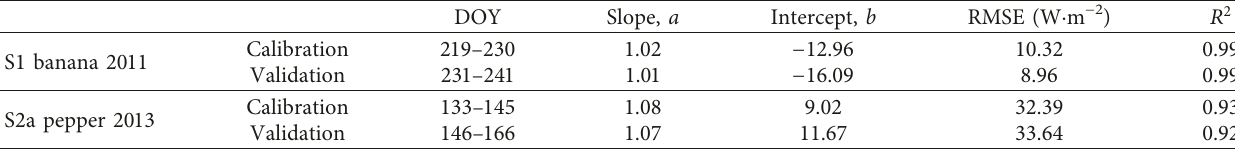
Figure 8: The latent heat flux estimated based on FV technique, LE FV , versus the one estimated by forcing the energy balance closure, S1 banana screenhouse: (a) calibration; (b) validation. S2 pepper screenhouse (above screen): (c) calibration; (d) validation. Statistical data of these graphs are presented in Table Table 7: Statistical variables for the regressions between latent heat fluxes deduced from energy balance and estimated by the FV method (Figure 8). DOY Slope, a